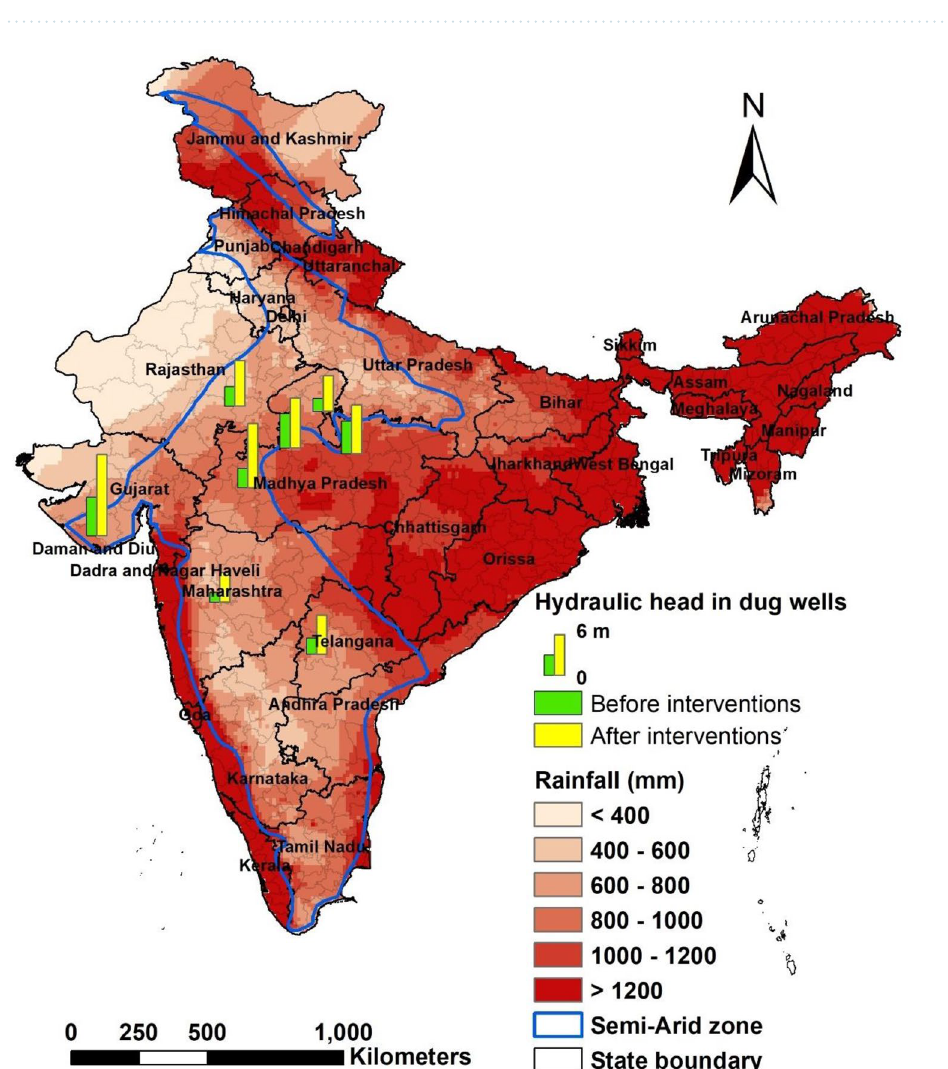
Figure 12. Impact of rainwater harvesting interventions on changes in groundwater status in October in benchmark